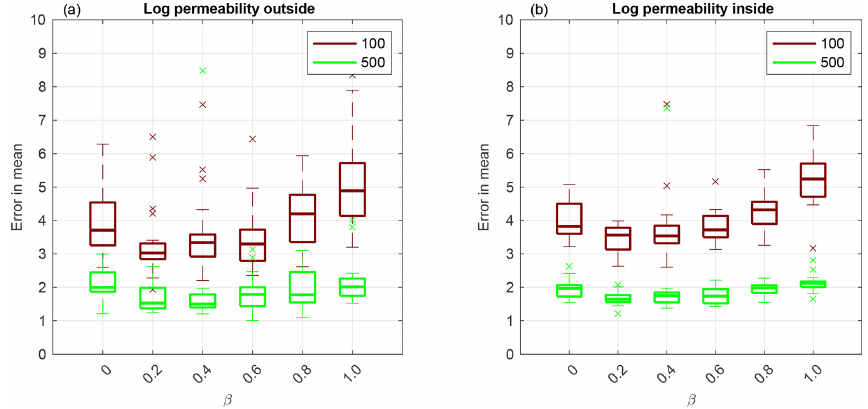
Figure 8. The same as Fig. 7 but using optimal transport